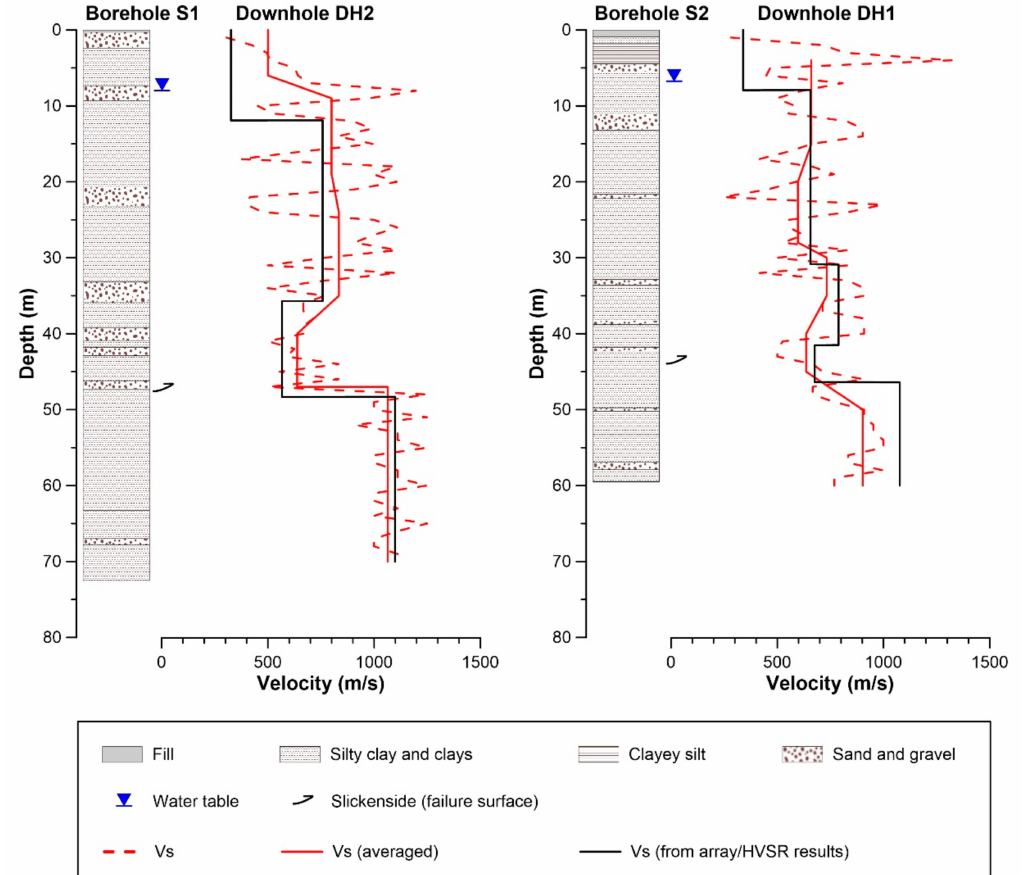
Figure 4. Soil columns and downhole results obtained at boreholes drilled in the landslide. The plot also depicts results obtained from the inversion of noise measurements at the same locations (see Figure 3 for location of the